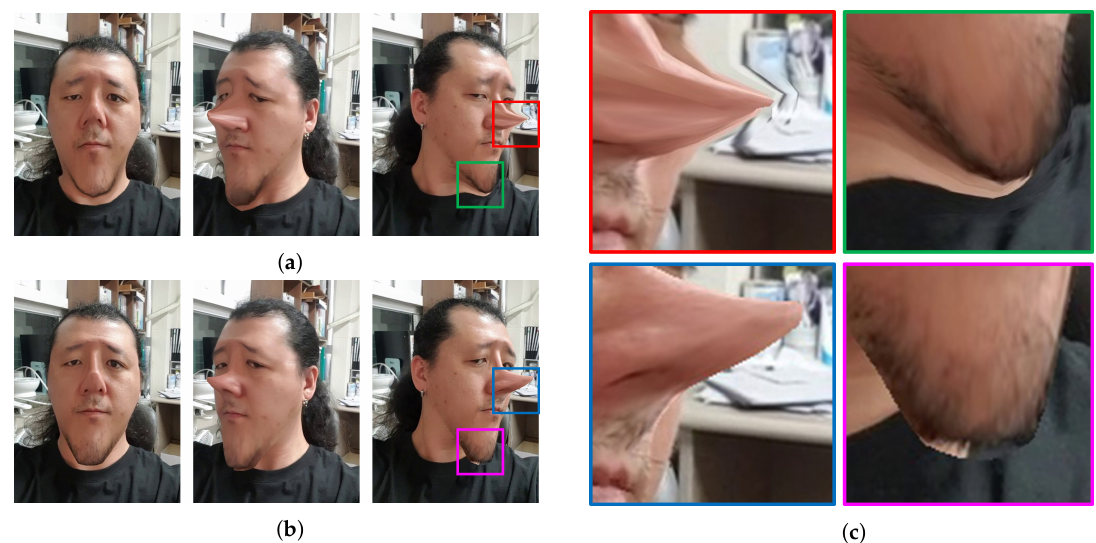
Figure 8. Comparison with existing application: ( a ) results from Plastic Surgery Simulator; ( b ) results from the proposed framework; and ( c ) magnifications of the color boxed in ( a , b ).